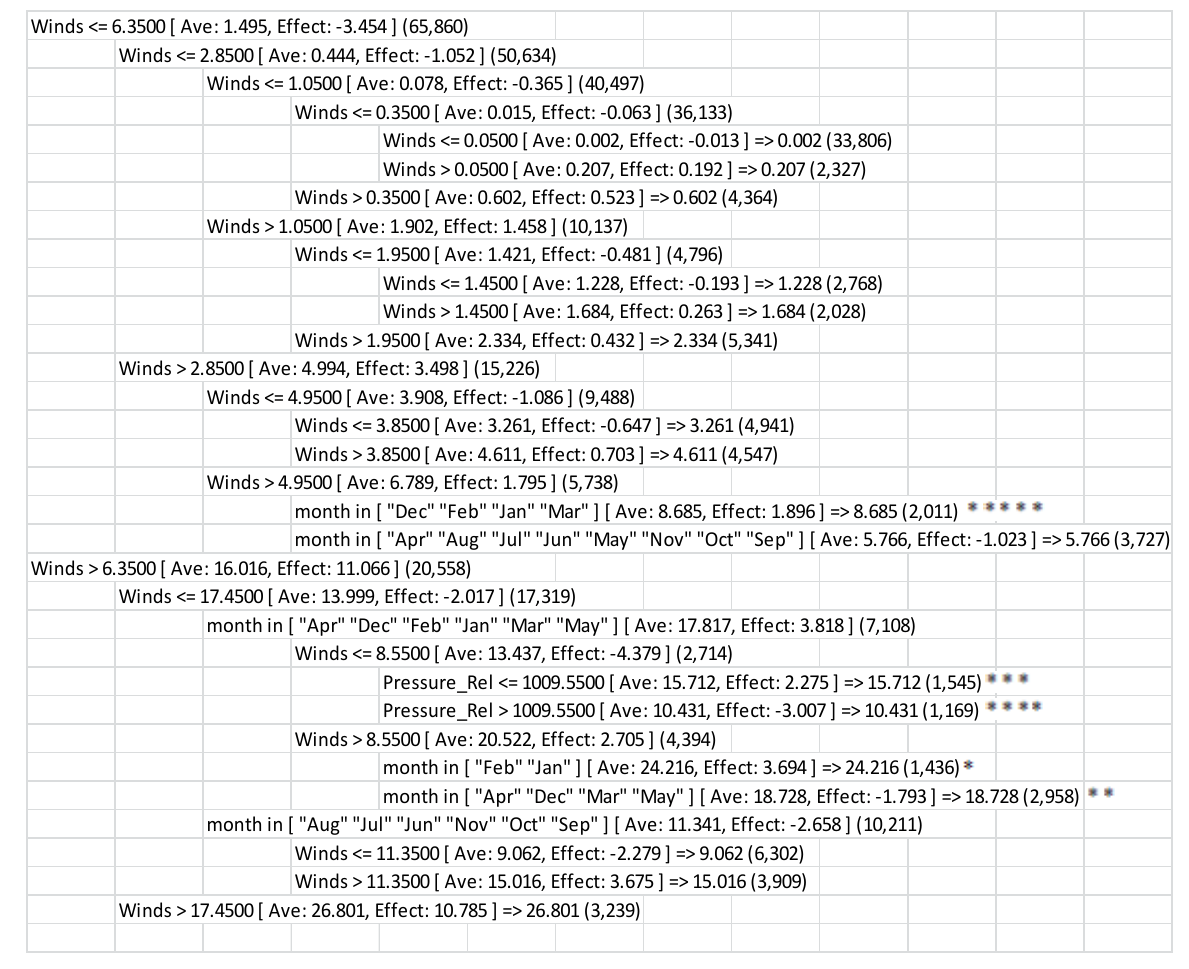
Figure 3. CRT tree rules for gust predictions show the rule sets relating to two major wind